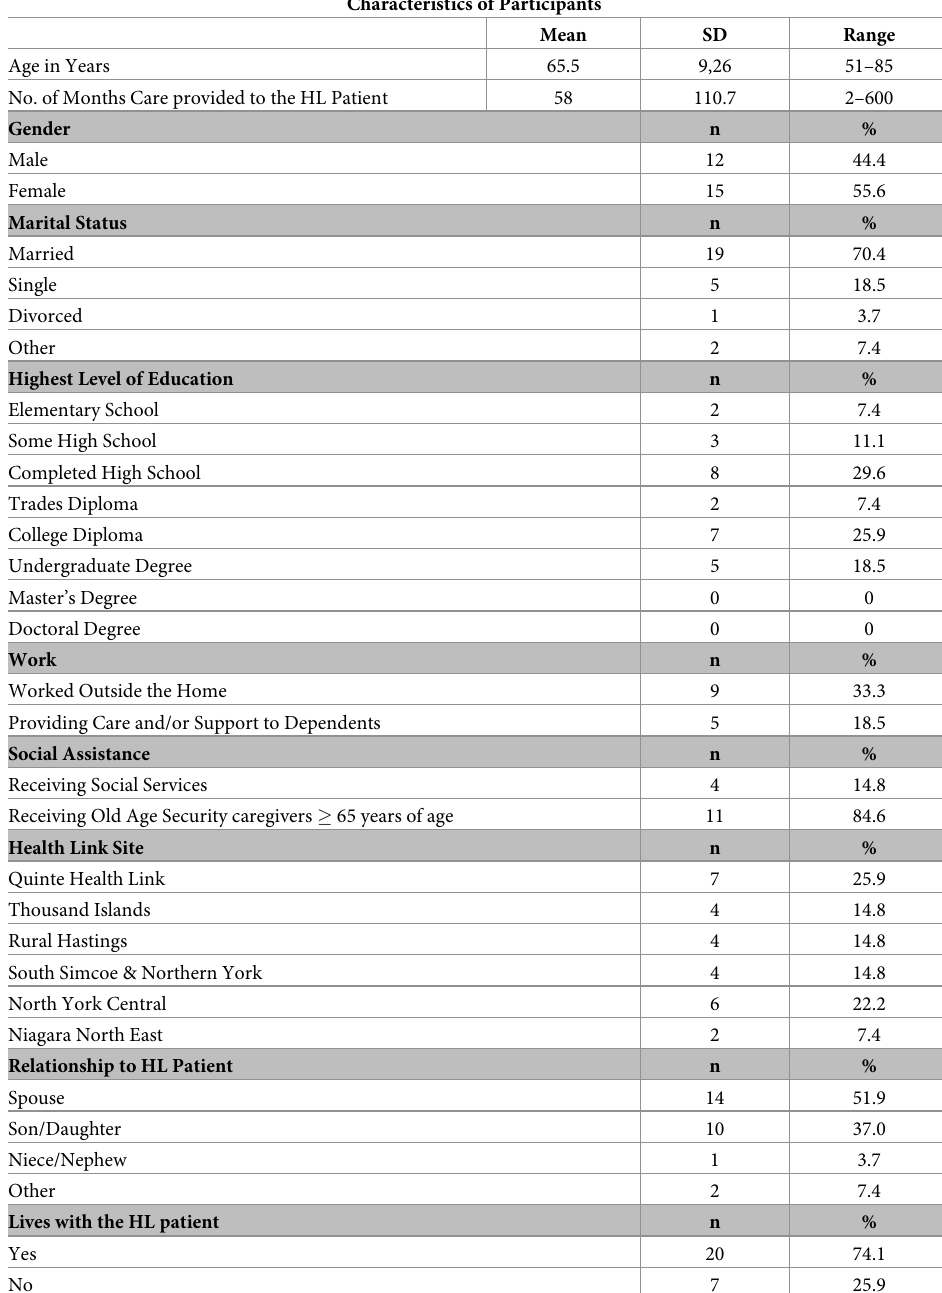
Table 1. Demographic characteristics of participants (n =